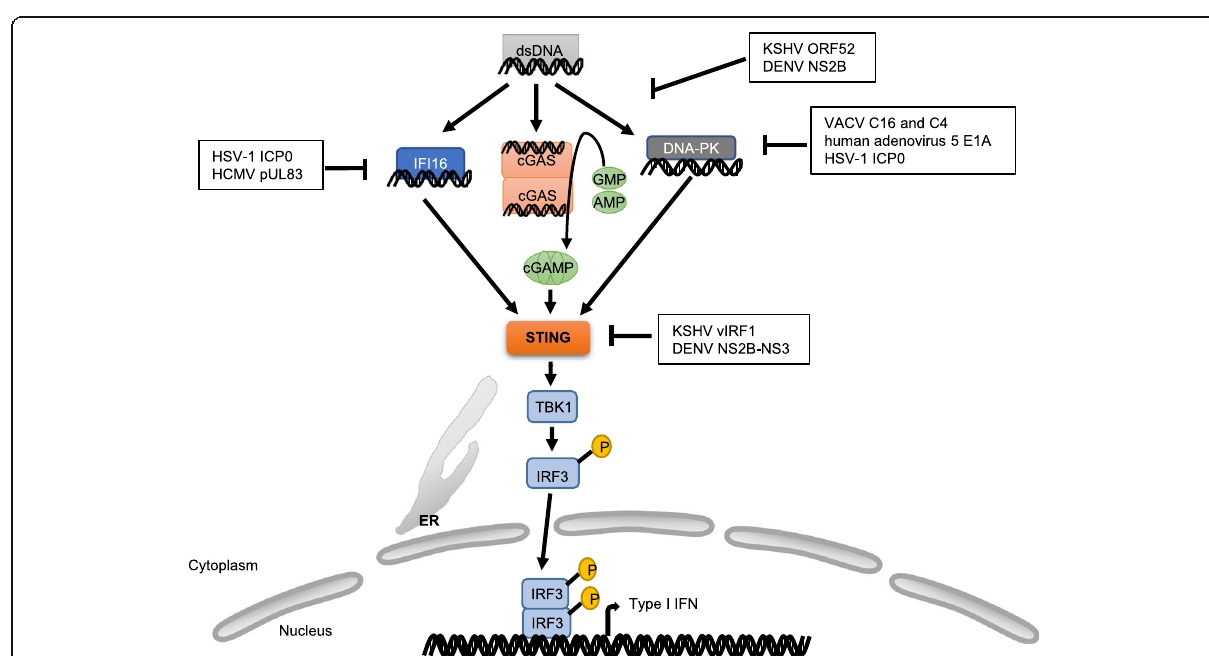
Fig. 4 Innate immune evasion strategies of targeting DNA signaling pathway. DNA signaling can be restrained by viral proteins that either interact with IFI16, cGAS, DNA-PK or STING directly or cause their